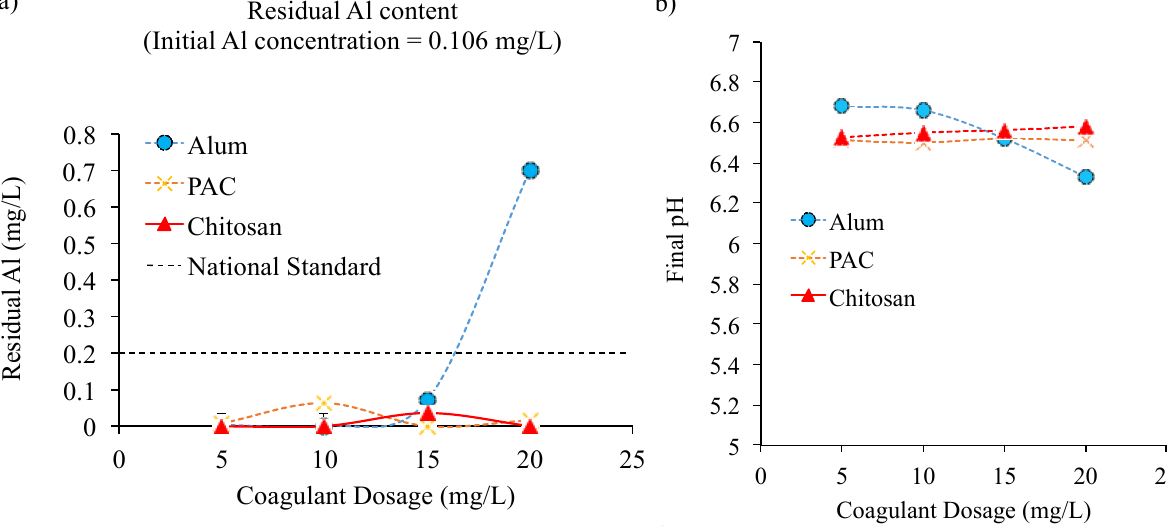
Figure 3. ( a ) Concentration of residual Al, Fe, and Mn in low water turbidity water using alum, PAC, and chitosan at dosages from 5 to 20 mg/L, and ( b ) the final pH after coagulation process using alum, PAC, and chitosan.